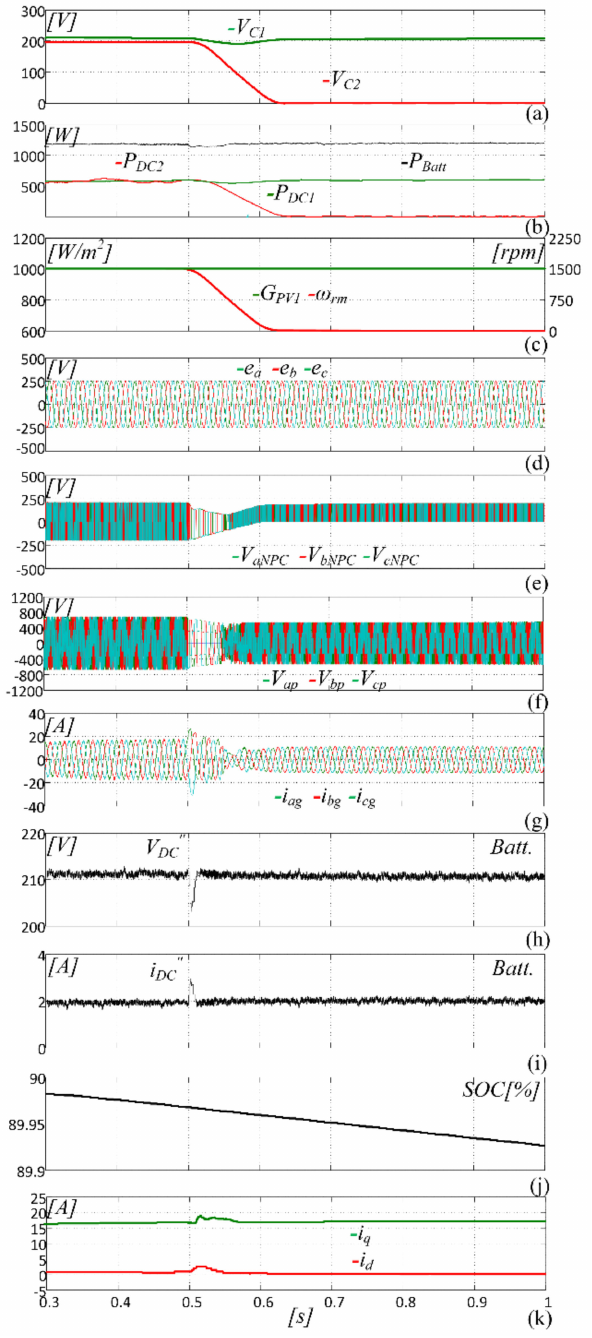
Figure 12. Six-level MMC-wind turbine (WT) shut-down G PV 1 = 1000 W/ m 2 . ( a ) V c 1 and V c 2 . ( b ) ES 1 , ES 2 , and ESS output power. ( c ) G PV 1 and PMSG rotor speed ω r . ( d ) Grid voltage. ( e ) NPC output voltage. ( f ) Primary voltage. ( g ) Grid current. ( h ) Battery voltage. ( i ) Current. ( j ) SOC . ( k ) Output d , q axes